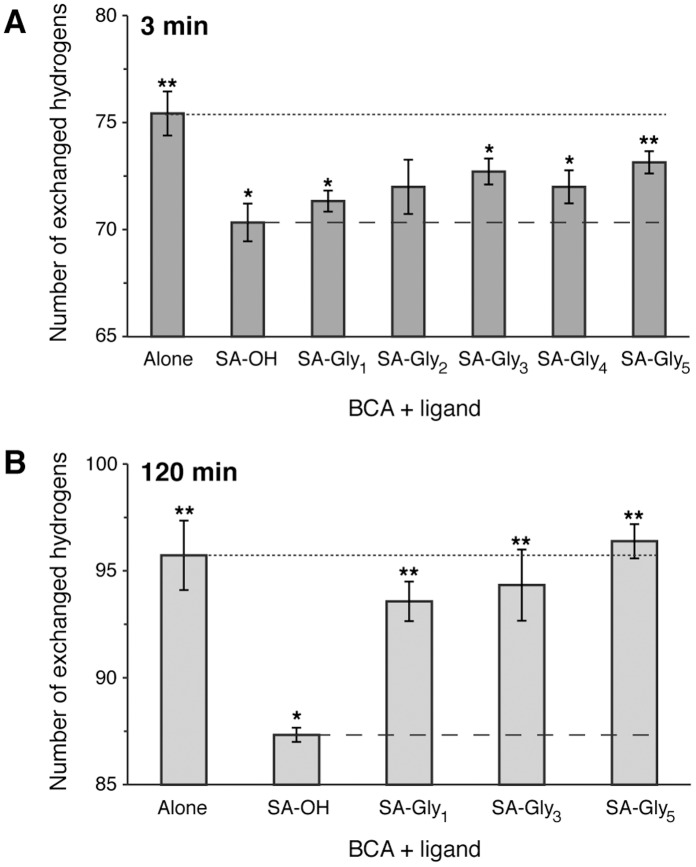
Number of hydrogens in BCA that exchange with deuterium after treatment with or without SA-Glyn ligand.Exchange studies were conducted after incubation in D2O for 3 min (A) or 120 min (B), and in both cases reveal a slight trend towards more exchanged protons with increasing length (n) of the SA-Glyn ligand. Levels of statistical significance (Student’s t-test, p<0.05) are indicated with an ‘*’ for significance over BCA alone (denoted with dotted lines) and ‘**’ for significance over BCA treated with p-carboxybenzensulfonamide, SA-OH (denoted with dashed lines). Error bars represent standard errors of the mean of at least five measurements.